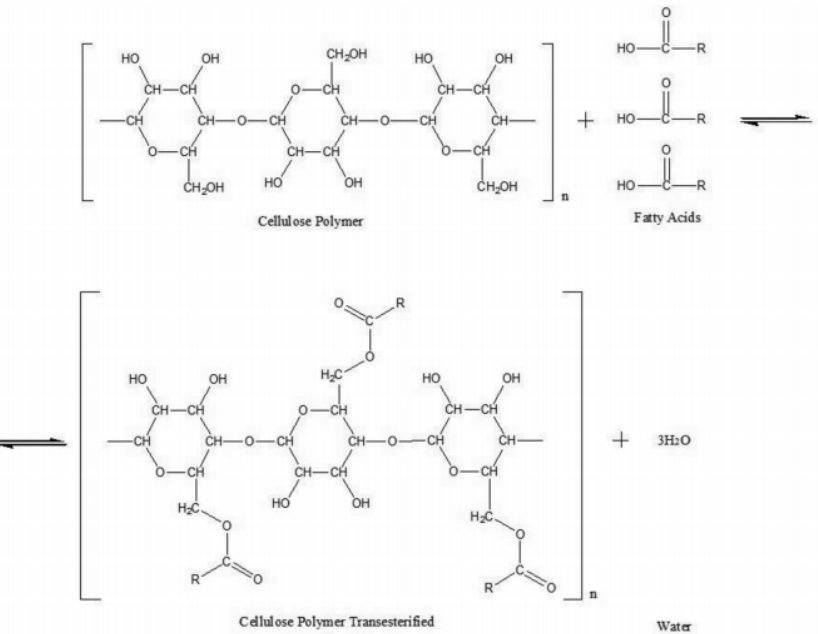
Figure 7. Transesterification reaction of cellulose.